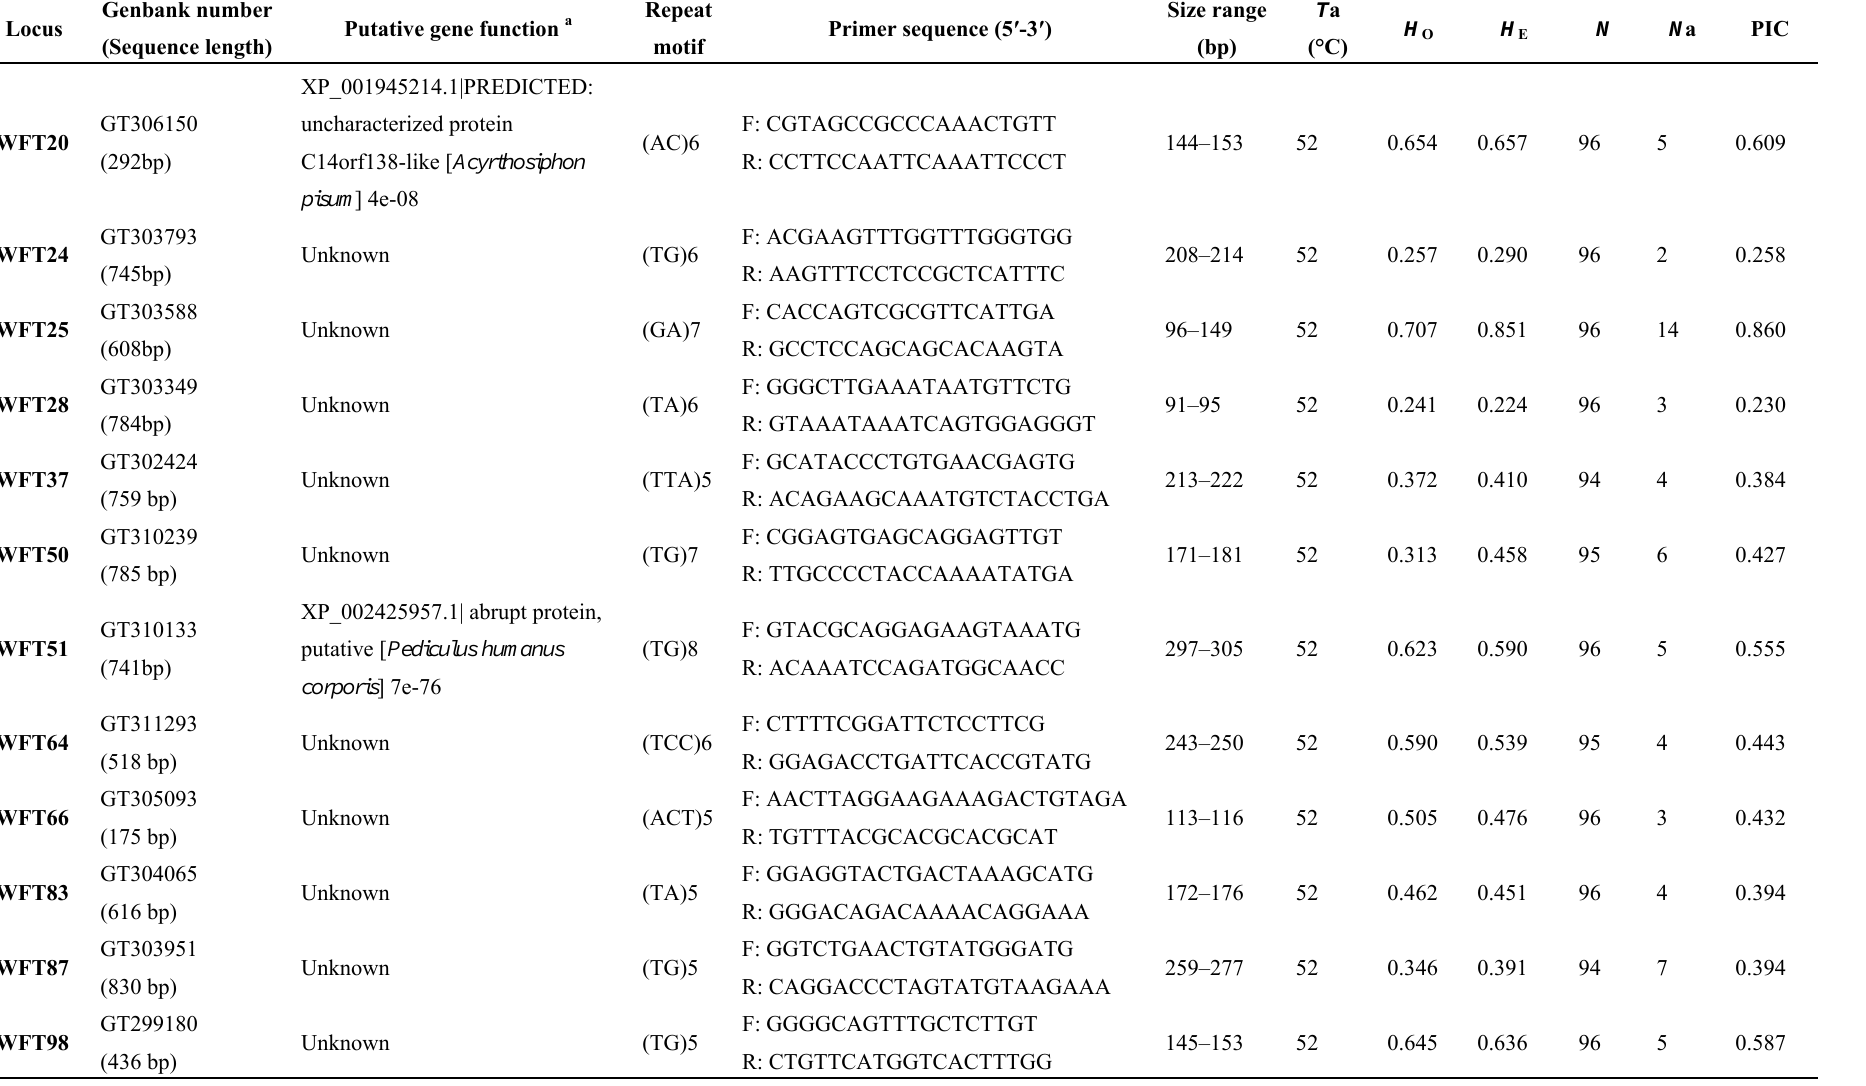
Table 2. Characteristics of 18 new EST-SSRs in Frankliniella occidentalis